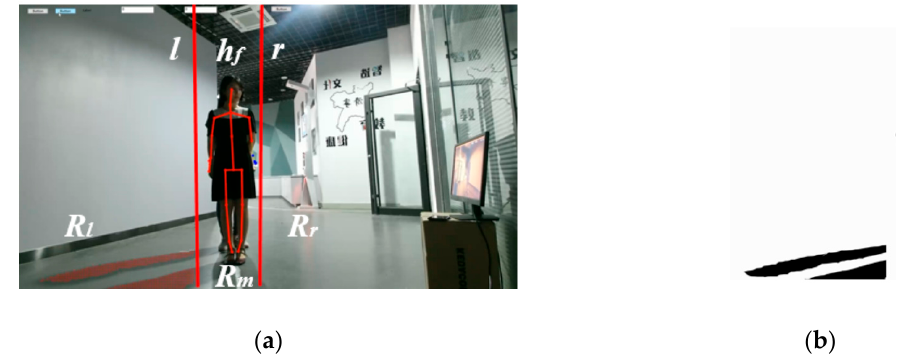
Figure 5. The skeleton space of the Kinect and the transformation relationship between RGB image space and skeleton space. space and skeleton space.